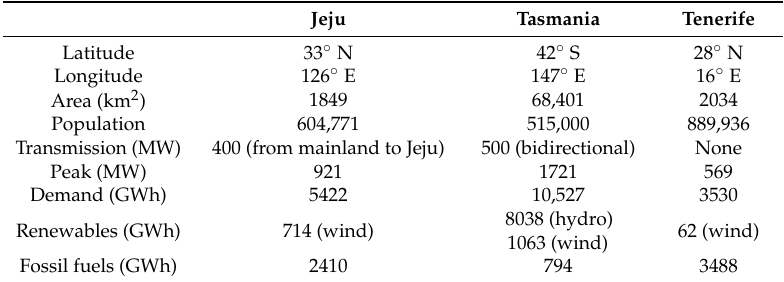
Table 1. Three case-study islands (Jeju, Tasmania and Tenerife), giving their geographical location, land area, population, peak and annual demand, annual renewable and fossil-fuel supply shares, and transmission-connection to the mainland grid.